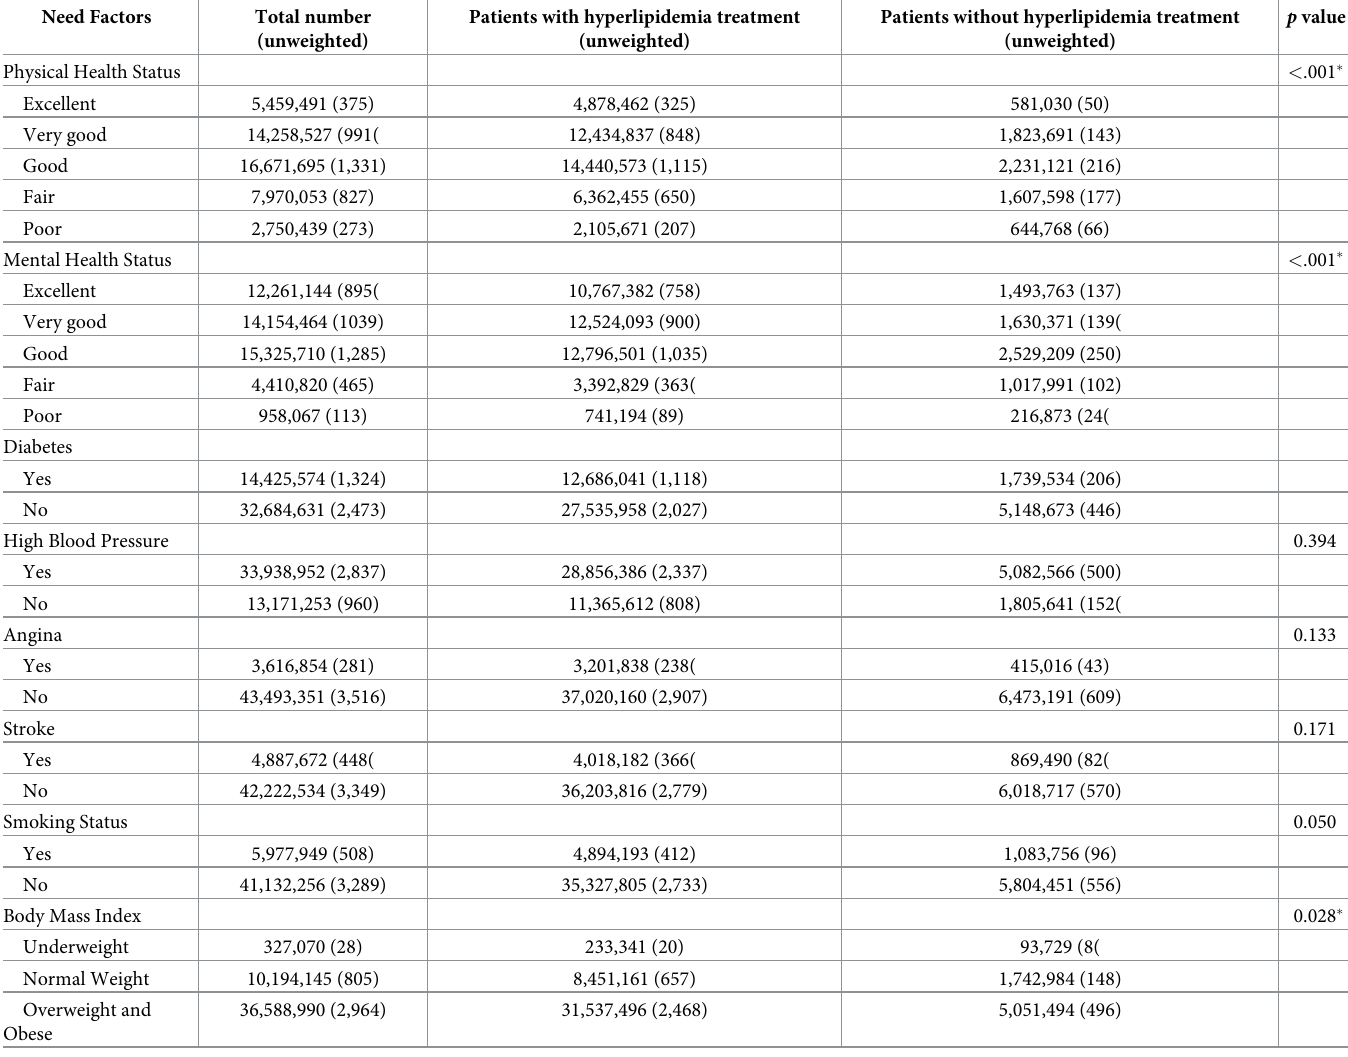
Table 3. Population characteristics; need